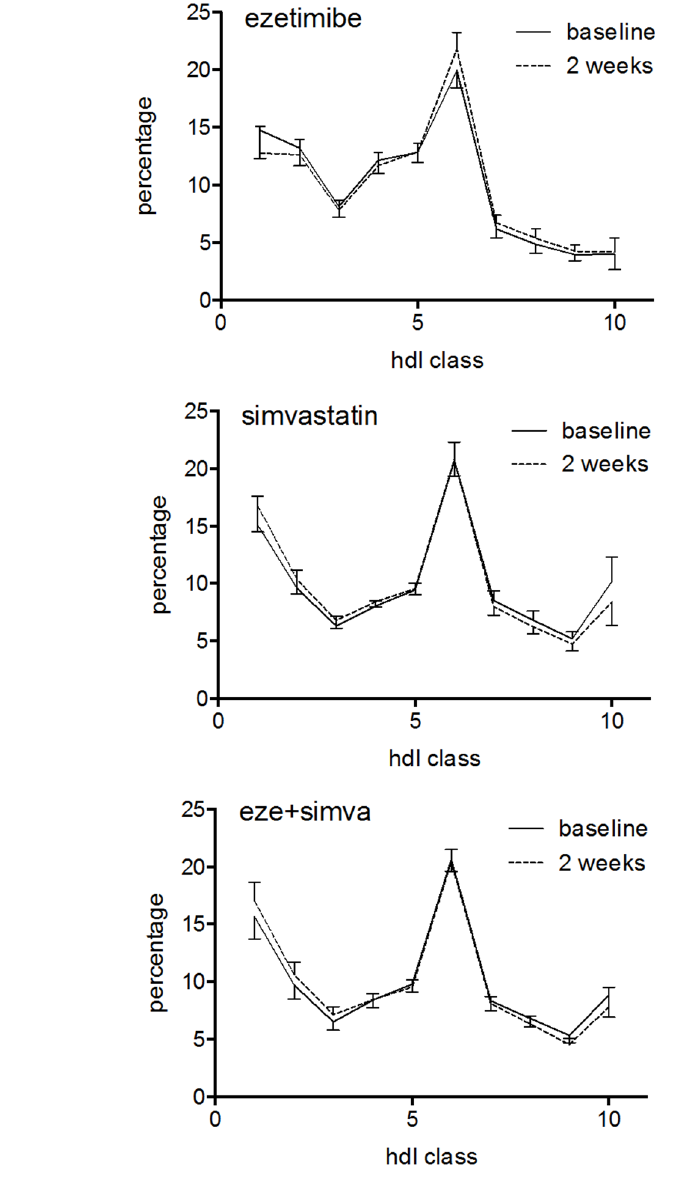
increased large and decreased small HDL, while ezetimibe had the opposite effect. Table 5 shows the results of multivariate regression modeling. In all models, HDL subclass composition after 2 weeks was the outcome parameter and all models were adjusted for the respective baseline HDL subclass composition. In model 1 (basic model) we analyzed the main treatment effects and found significant effects on large and intermediate HDL. In comparison to ezetimibe, simvastatin or the combination significantly increased large HDL by 3.5 or 3.7 percentage points (P= 0.053 or 0.036, respectively) and significantly decreased intermediate HDL by 2.9 or 3.3 percentage points (P= 0.009 or 0.003, respectively). There was no significant effect observed on small HDL.